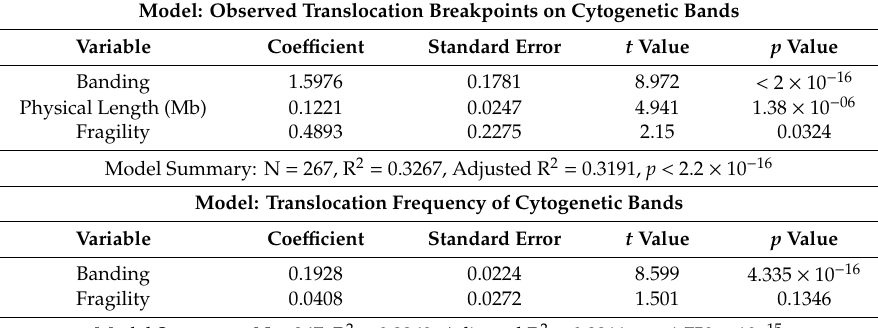
Table 9. Multiple linear regression analysis for translocation breakpoints and translocation